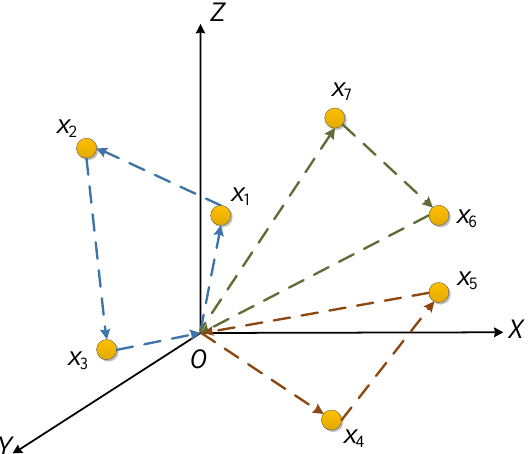
Figure 1. Unmanned aerial vehicle (UAV) task assignment and path planning model in the application scenario.